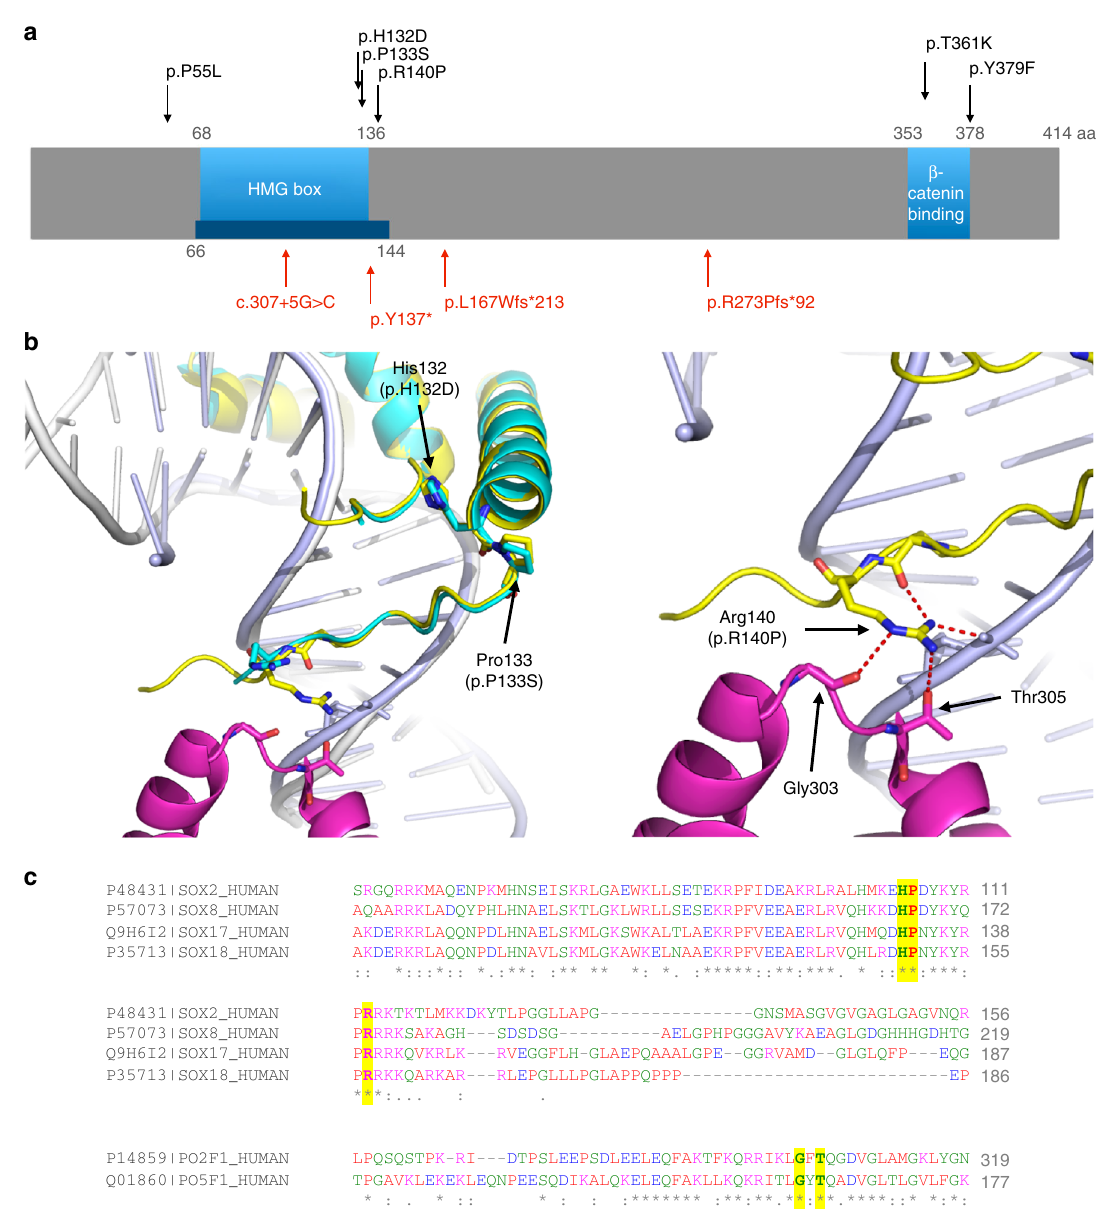
Fig. 8 Structural analysis of SOX17 mutations. a Schematic diagram of human SOX17 (Q9H6I2), based on UniProtKB annotation, and published reports 23 . Red arrows indicate PTVs and black arrows indicate missense mutations identi fi ed in PAH patients. The blue bar illustrates the region that is covered in the crystal structure (PDB: 3F27) 64 . The ability of SOX17 to activate transcription of target genes correlates with binding to β -catenin 23 . As illustrated, all PTVs lead to a loss of the β -catenin binding region. Two missense mutations are located within and very close to the minimum β -catenin binding regions, and both are highly conserved, indicating they are likely to be important for β -catenin binding. b Structural analysis of HMG domain missense mutations found in PAH patients. Left, Superposition of SOX17/DNA structure (Sox17: cyan, DNA: grey) 64 onto SOX2/DNA/Oct1 structure (PDB: 1GT0, Sox2: yellow, Oct1: magenta, DNA: light blue) 24 . Right: Magni fi ed view of the interactions around Arg140 in the SOX2/DNA/Oct structure. Arg140 in SOX2 makes multiple H-bond interactions and mutating this Arg in SOX2 abolishes the interaction with transcription factors Pax6 and Oct4 24 . SOX2 and SOX17 both bind to Oct4 65 and SOX17 K122E mutant can replace SOX2 in maintaining stem cell pluripotency 65 , indicating this region in SOX17 may interact with Oct4, similar to SOX2. The three missense mutations in SOX17 will likely disrupt interaction with Oct4. c Supporting the analysis in b , sequence alignment shows that the HMG domain of SOX2 (P48431) and SOX17 as well as SOX8 (P57073) and SOX18 (P35713) share high sequence identity and the three mutations found in PAH (highlighted in yellow) are highly conserved emphasising their functional importance. Similarly, the Gly and Thr that interact with Arg140 in SOX2 (highlighted in yellow) are also conserved between Oct1 (PO2F1) and Oct4